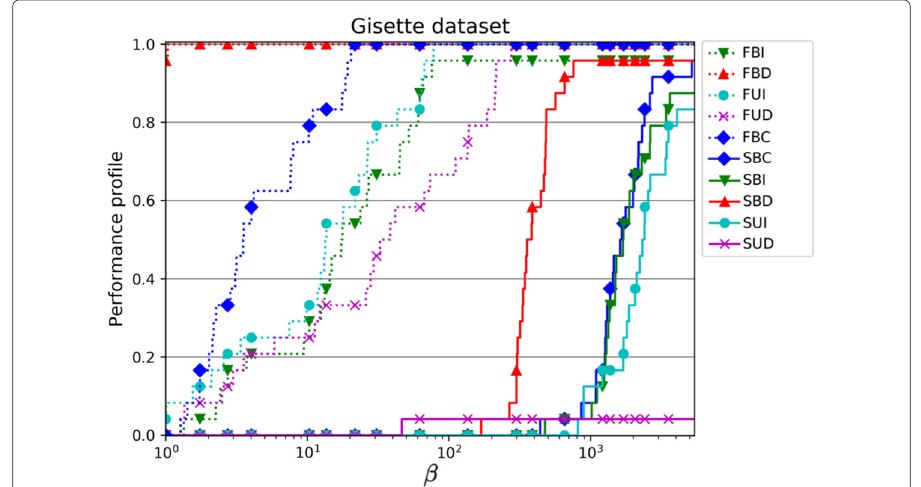
Figure 16 represents the performance profile for the YearPredictionMSD data set.